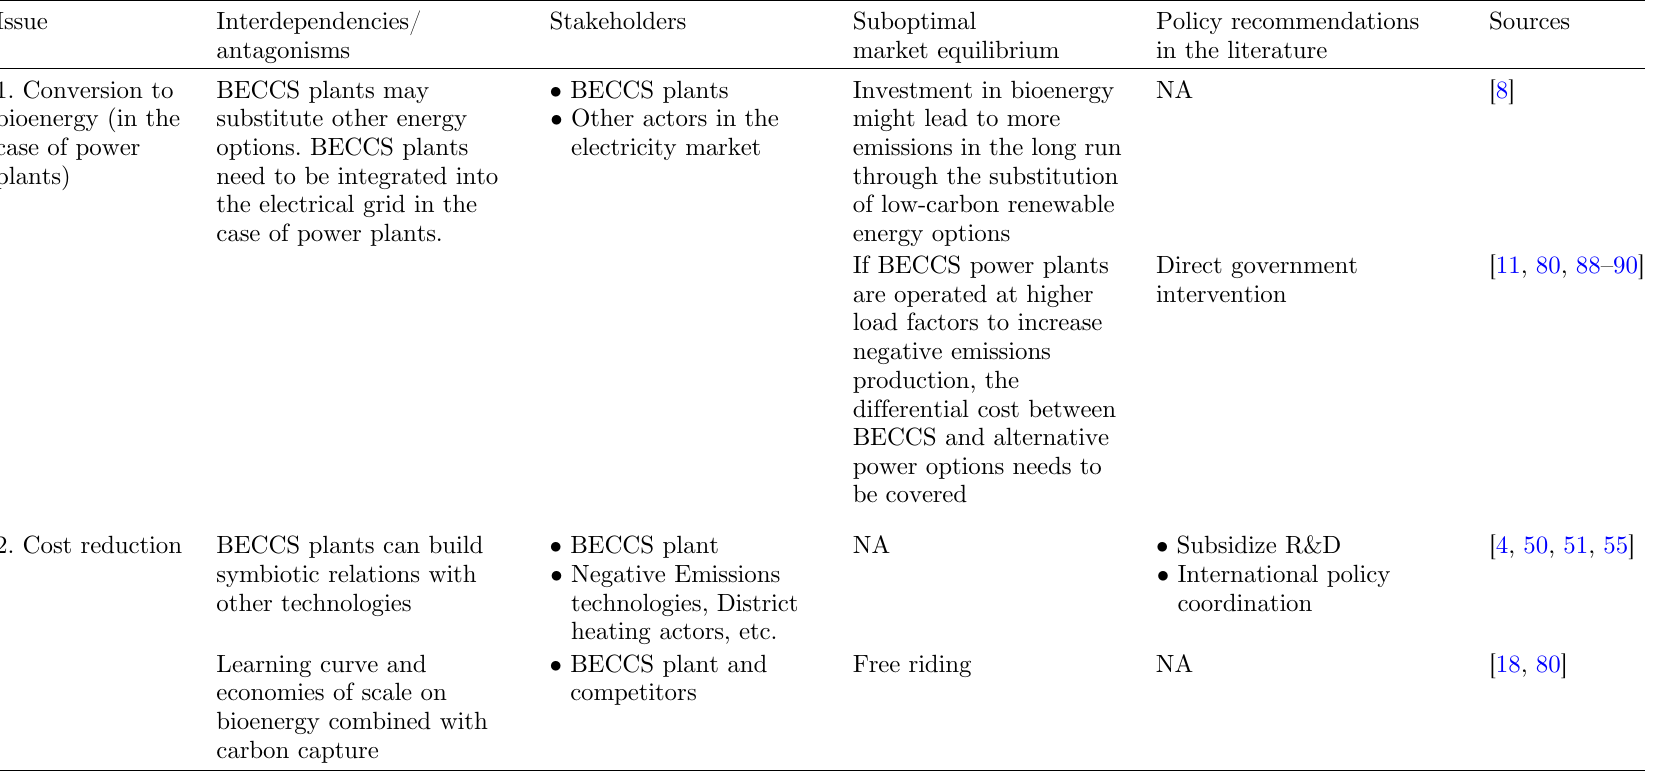
Table 3. Bioenergy with carbon